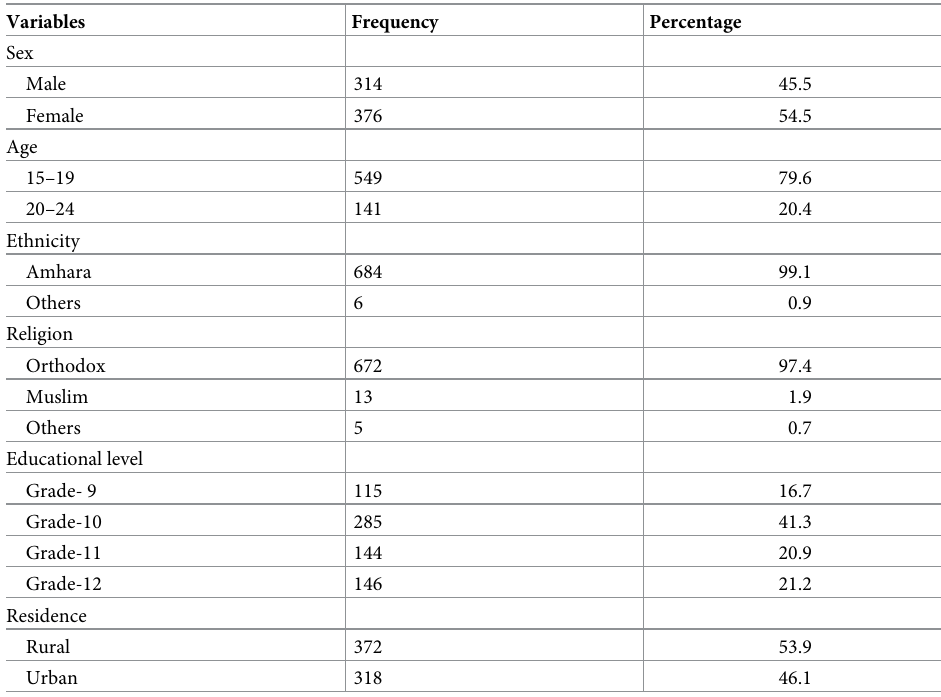
Table 1. Socio demographic characteristics students, Debre Tabor, Ethiopia,